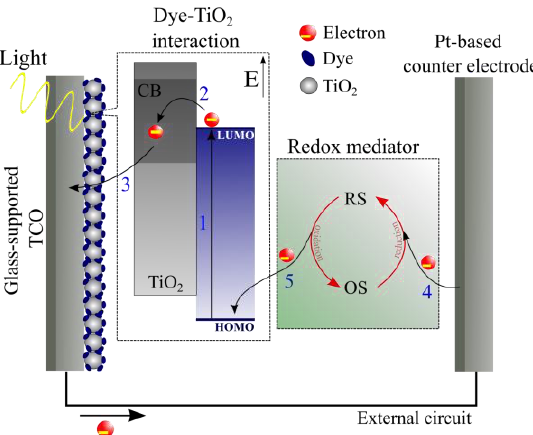
Figure 6. Illustration of the operation of a common DSSC: (1) photoexcitation of dye molecules, (2) electron injection to the semiconductor, (3) electron transport to the external circuit, (4) electron capture by redox couple, and (5) regeneration of oxidized dye molecules by electron transfer from redox couple. Here, CB = Conduction band, RS = Reduced species, OS = Oxidized species [73]. Different types of redox mediators have been evaluated over time. The triiodide/iodide (I 3– /I – ) is the most used due to its efficiency. However, some limitations exist when